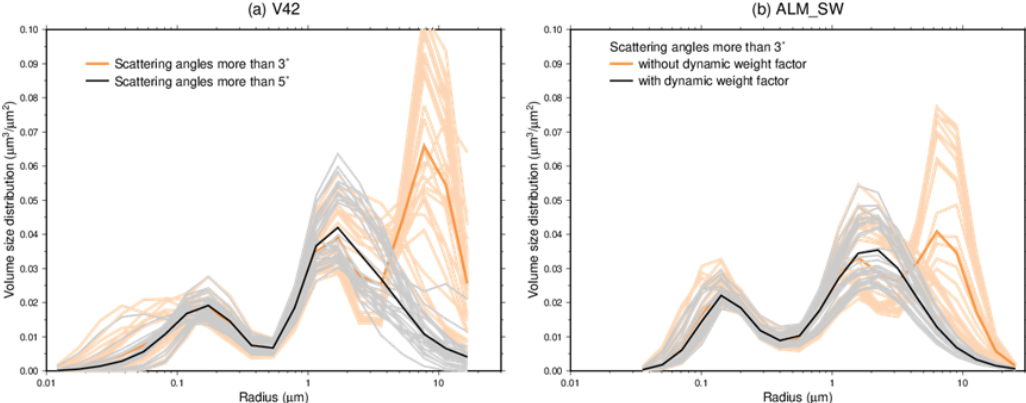
Figure 8. Retrieved volume size distribution in Tsukuba on 14 March 2018. (a) The results of the Skyrad v4.2 using the diffuse radiances at scattering angles more than 3 ◦ (orange) and 5 ◦ (gray and black). (b) The results of MRI v2 using the diffuse radiances at a scattering angle more than 3 ◦ and with (gray and black) and without (orange) the dynamic weight factor in Eq. (5). The thick lines are daily means.